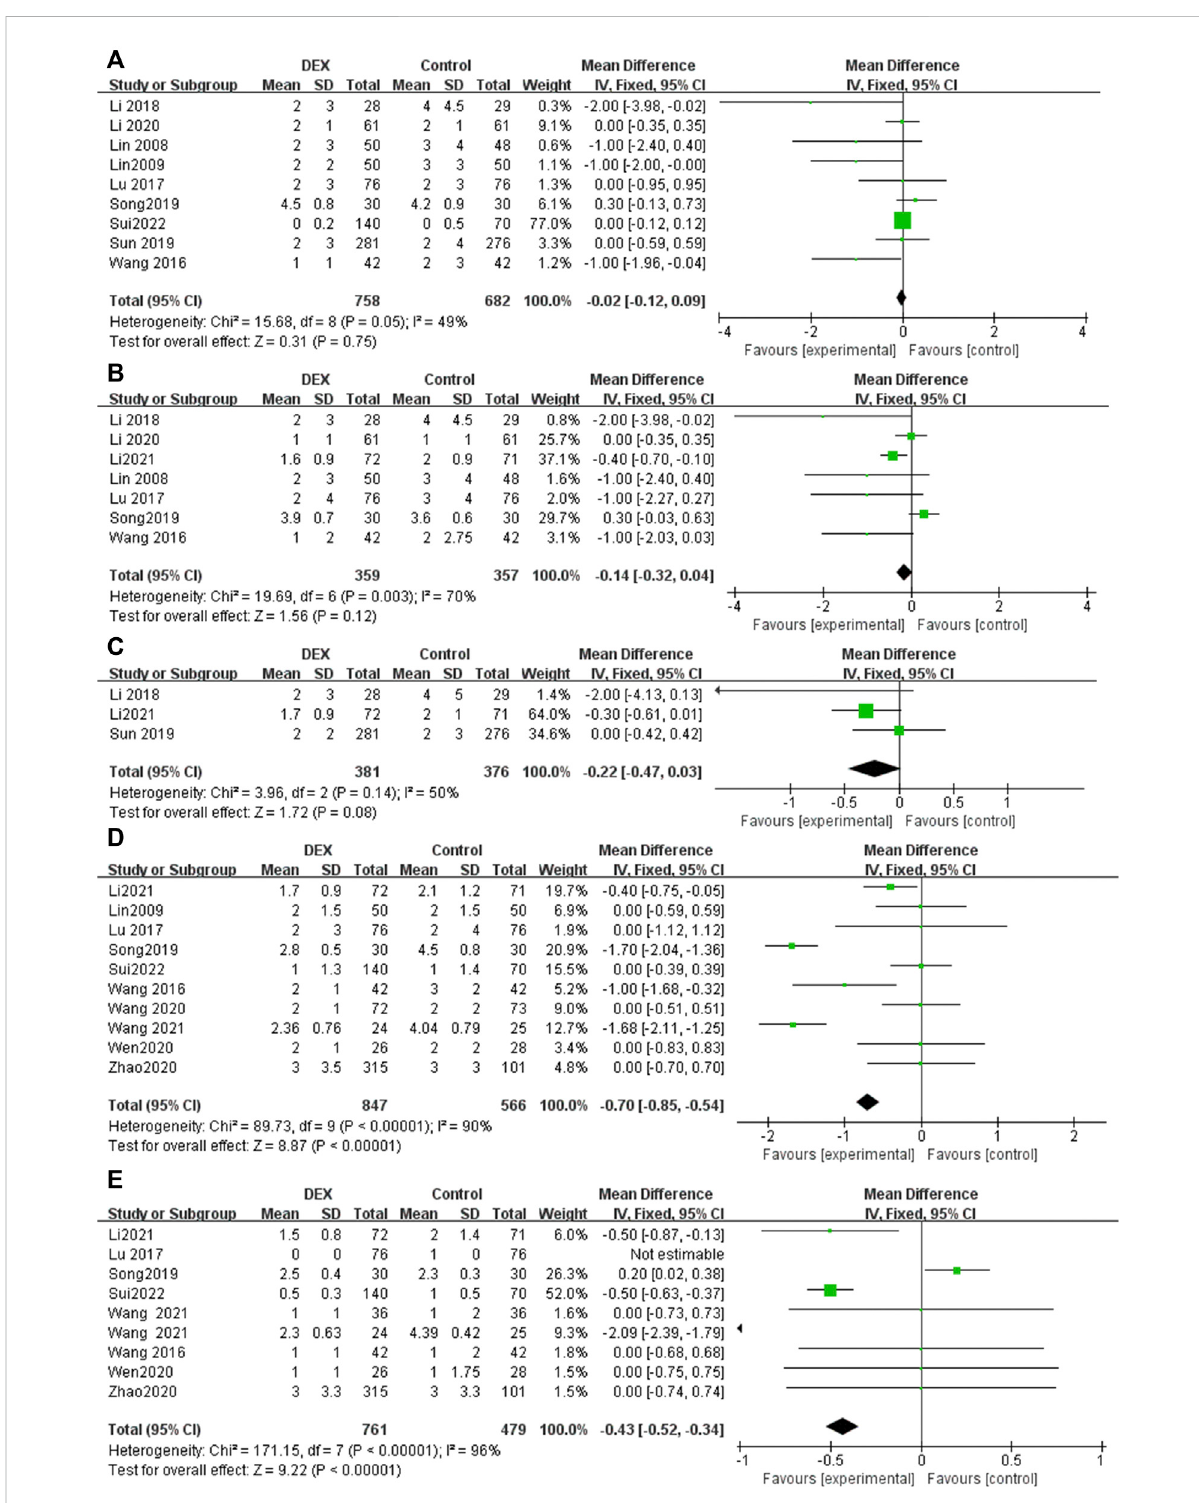
FIGURE 3 ForestplotforpainscoreinpostoperativePCIApatientsatdifferenttimepoints. (A) Painscoreat0 – 4 h, (B) Painscoreat4 – 8 h, (C) Painscoreat 12 h, (D) Pain score at 24 h, (E) Pain score at 48